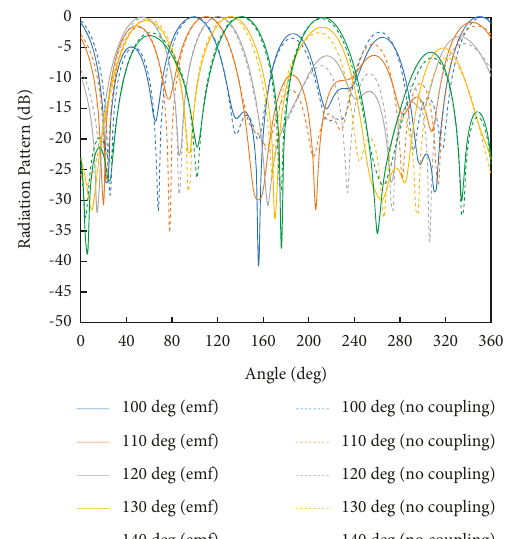
Figure 2: Comparison between pattern multiplication and the induced EMF methods (without GA) when steering the main beam towards 100 ° –140 °